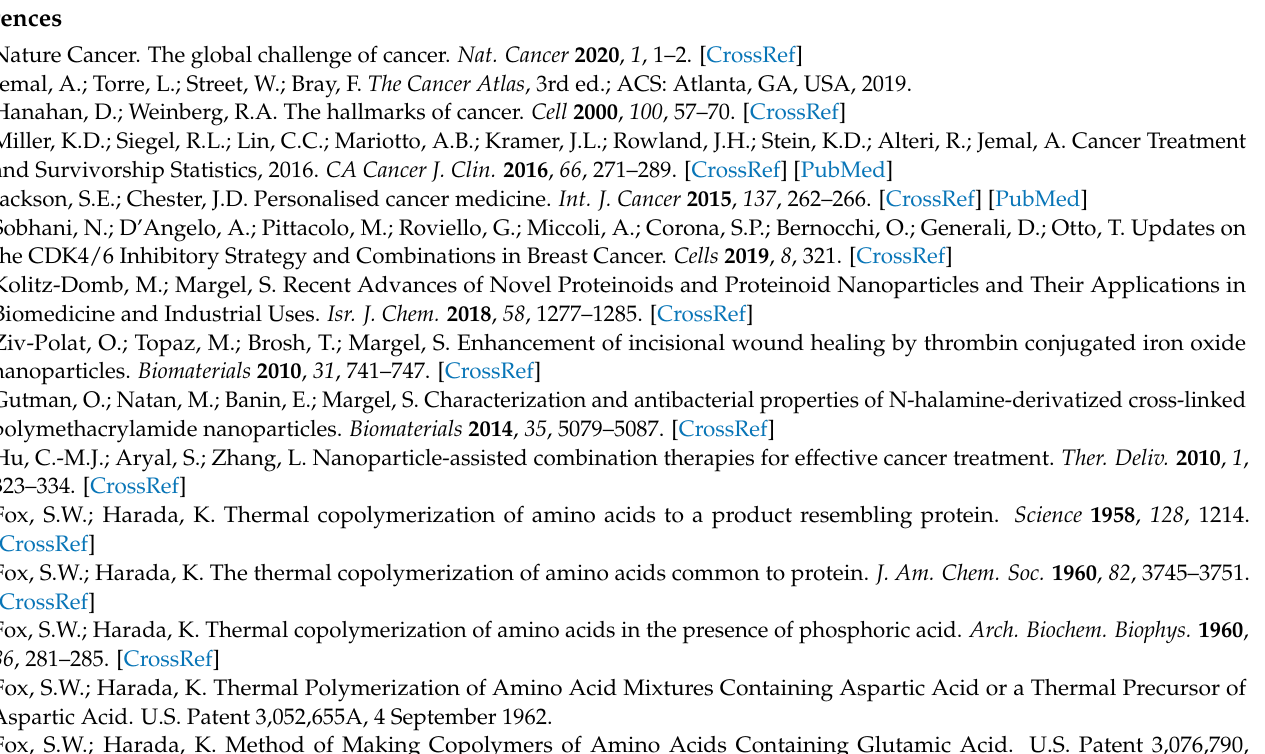
Figure S2: FTIR spectra of Alp, Pal, P(RGD) NCs and P(RGD)/Pal,Alp NCs. Figure S3: TGA thermo- grams of Alp, Pal, P(RGD) NCs and P(RGD)/Pal,Alp NCs. Figure S4: Tumor growth as function of time. In vivo tumor growth inhibition in PDX mice using Pal, Alp and mixed (Pal + Alp)